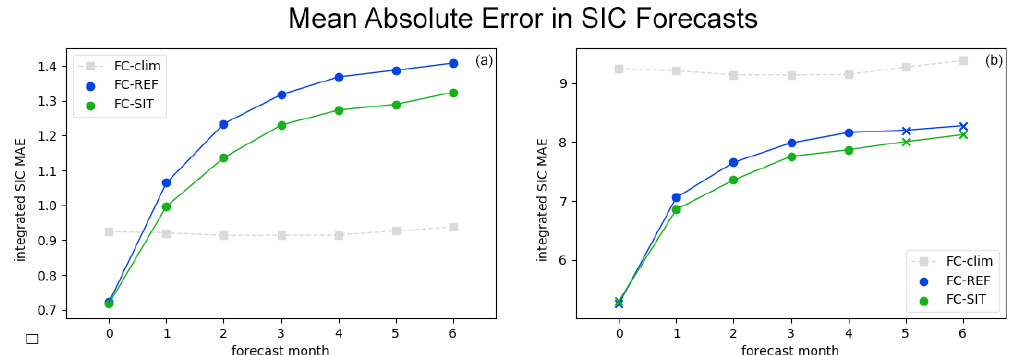
Figure 7. Spatially integrated SIC mean absolute error over lead month for all FC-REF and FC-SIT forecasts (72 forecasts each first of the month from January 2011 to December 2016) with respect to OSI-401-b observations. Panel (a) shows the error in 10 6 km 2 without bias correction and panel (b) the error in 10 5 km 2 after bias correction. Lead months for which the reduction of forecast error in FC-SIT passes a statistical significance test at the 5% level (DelSole and Tippett, 2016) are marked by filled circles, and insignificant changes are marked by crosses. The error of a simple climatological reference forecast is also shown as FC-clim.